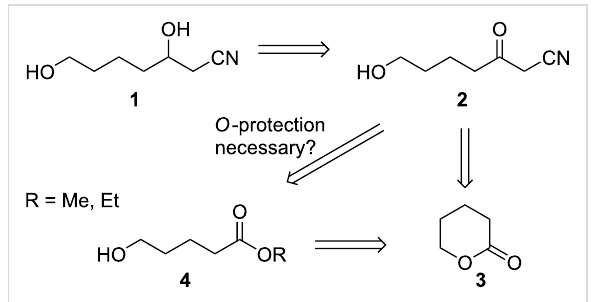
Scheme 1: Proposed retrosynthesis of the free diol 1